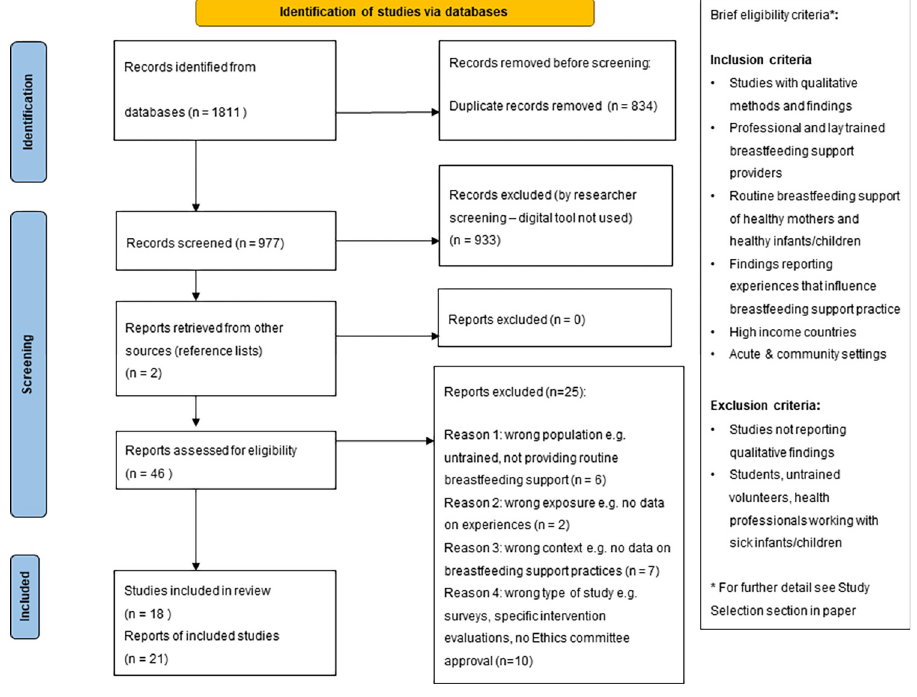
Fig 1. PRISMA flow